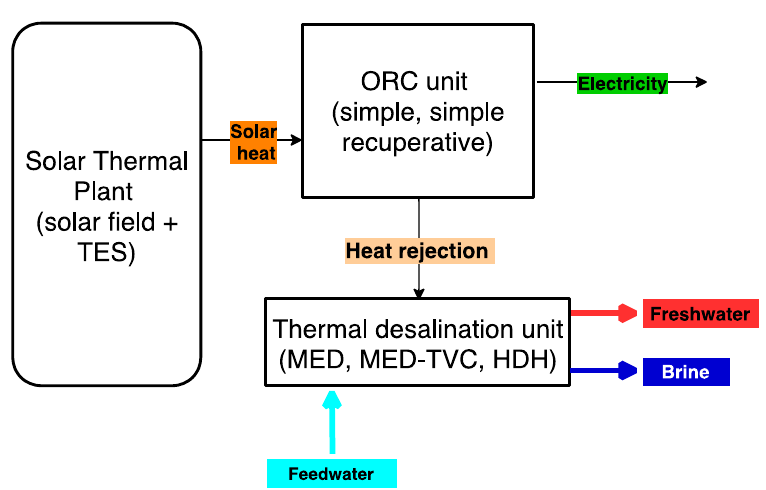
Figure 4. Integration of thermal desalination processes in solar-ORC-based poly-generation sys-